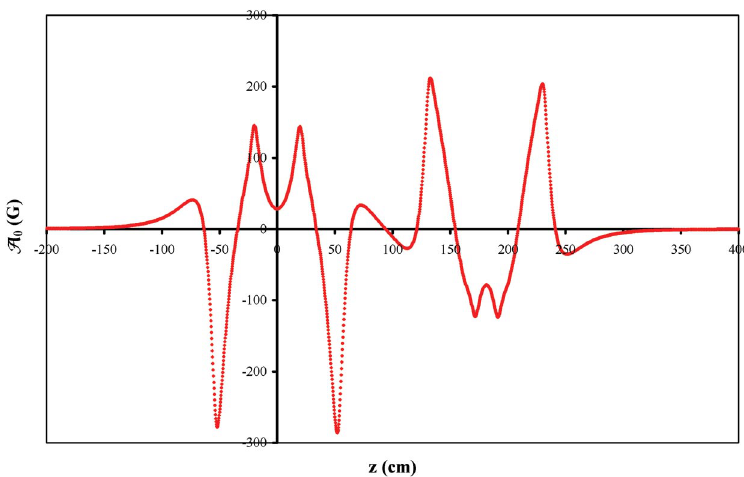
FIG. 7. (Color) Component A